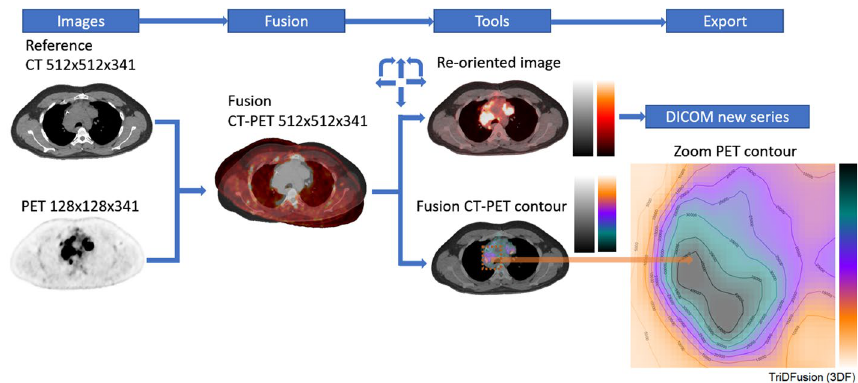
Fig. 4 Image fusion workflow using computed tomography (CT) and positron emission tomography (PET)